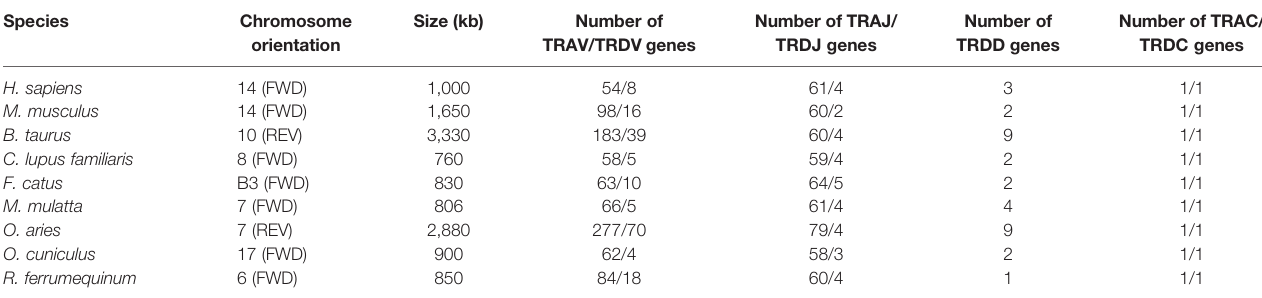
TABLE 1 | Statistical analysis of TRA/D loci in humans ( Homo sapiens ), mice ( Mus musculus ), cows ( Bos taurus ), dogs ( Canis lupus familiaris ), cats ( Felis catus ), rhesus monkeys ( Macaca mulatta ), sheep ( Ovis aries ), rabbits ( Oryctolagus cuniculus ), and bats ( Rhinolophus ferrumequinum ).